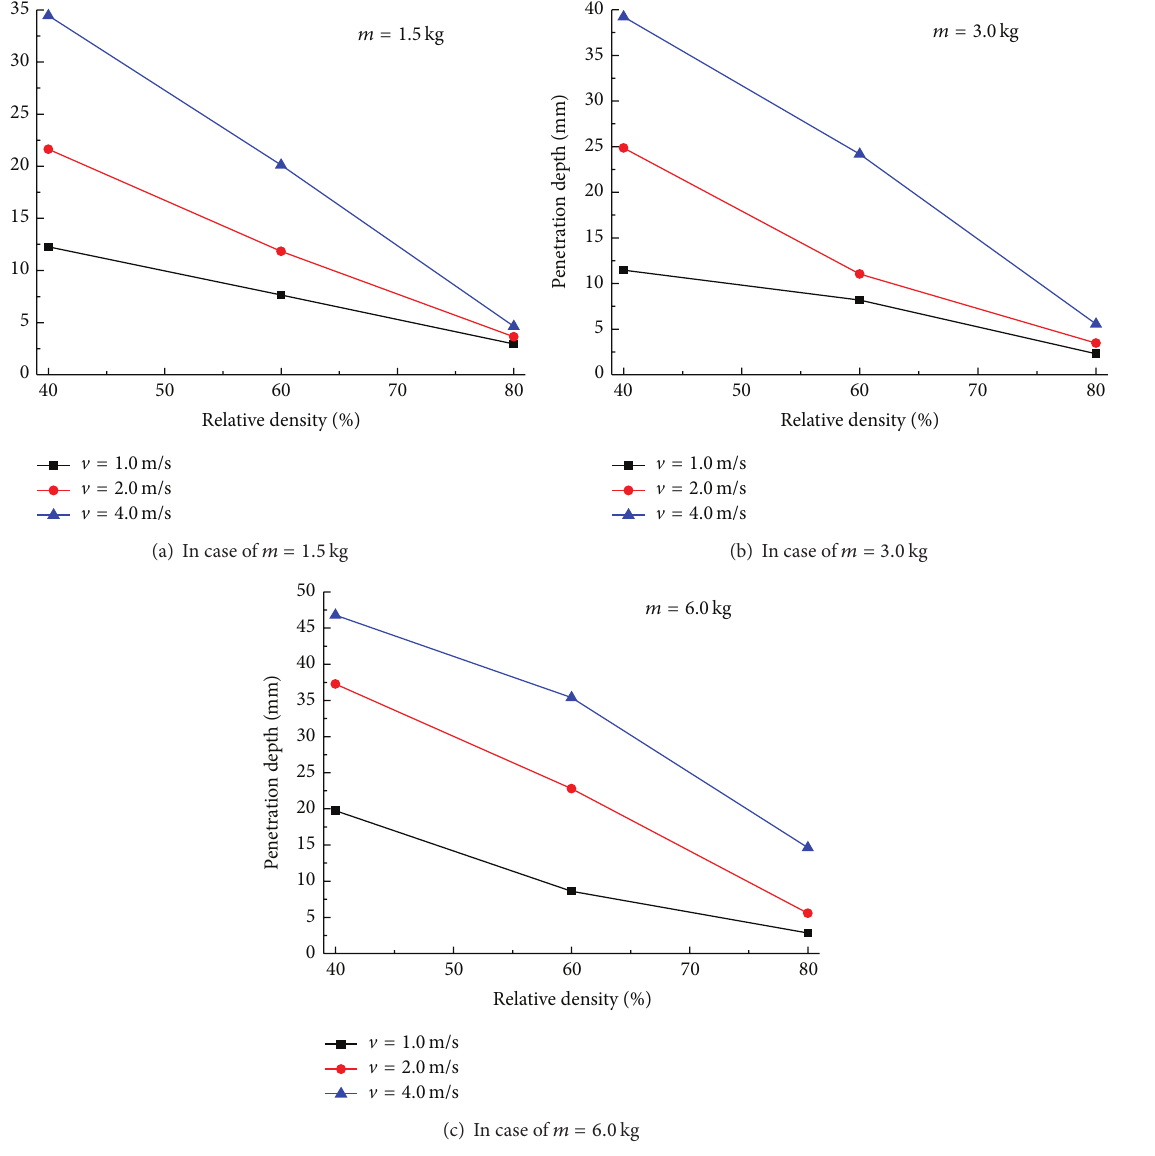
Figure 17: Effect of relative density on penetration